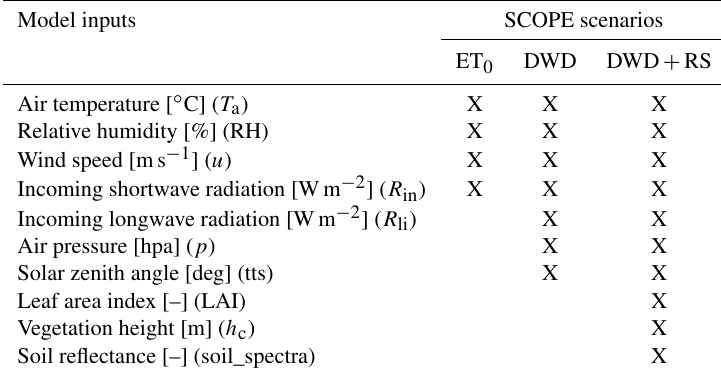
Table 2. Input parameters which vary hourly for each SCOPE